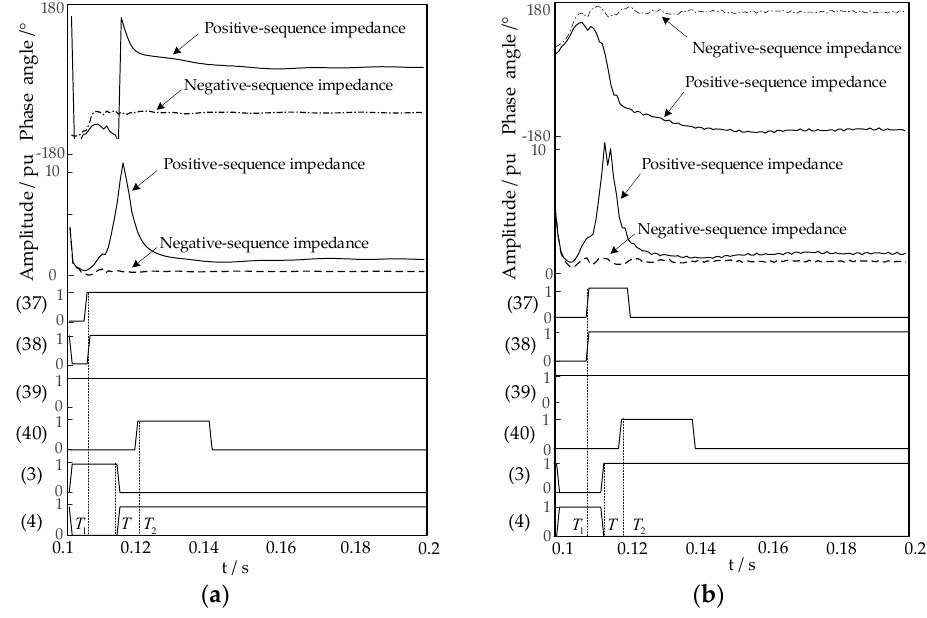
Figure 21. Performances of the mitigation countermeasure in Case 6: ( a ) busbar n ; and ( b ) busbar m .